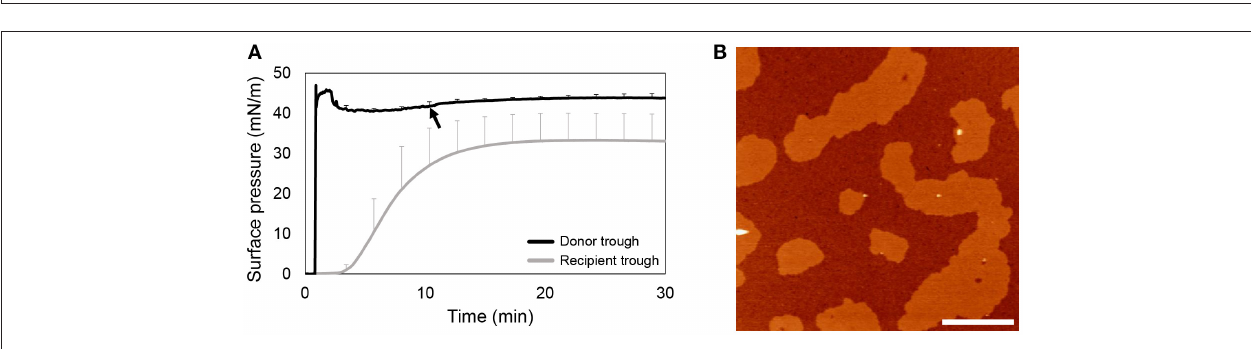
difference in height of 5.5 ± 0.89 Å (mean ± SD)